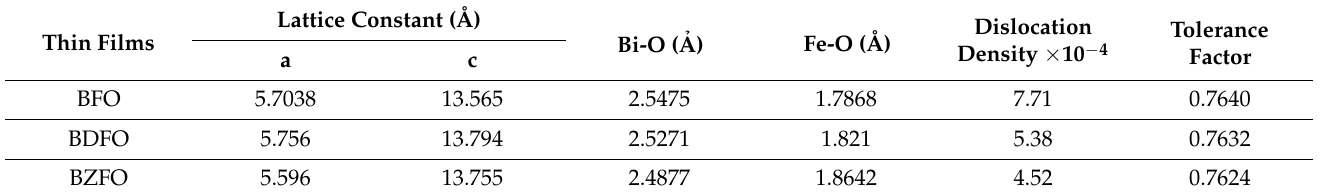
Table 1. Lattice constant, bond length, and dislocation density of BFO, BDFO, and BZFO thin films.